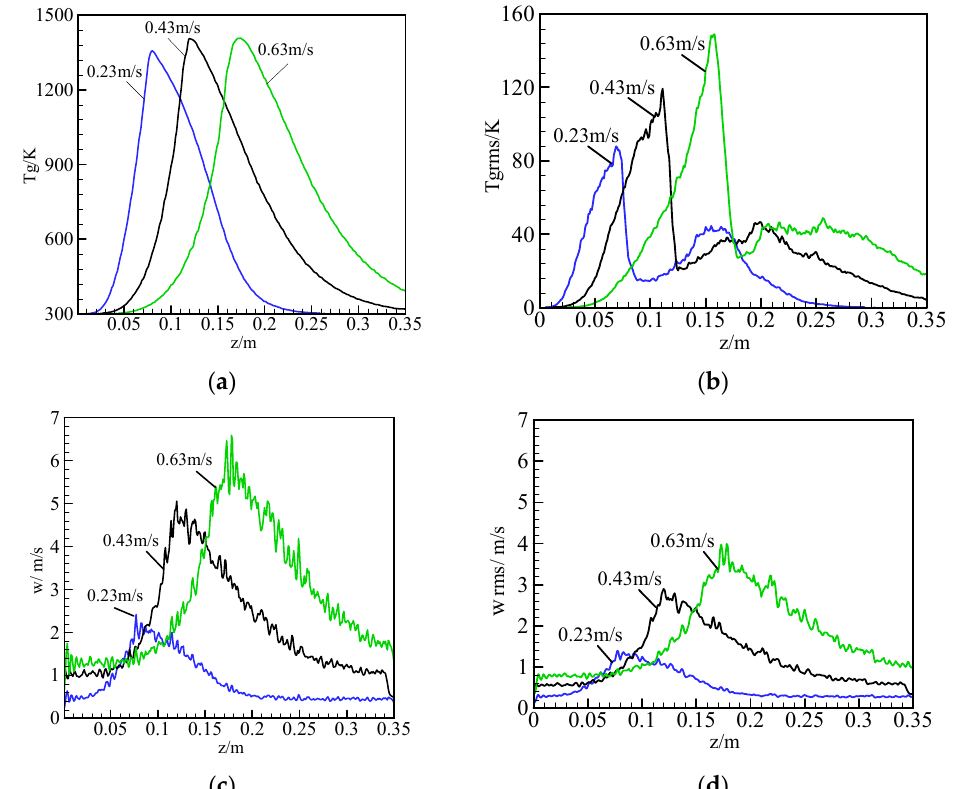
Figure 8. Effect of mixture velocity for average gas temperature and its root mean square, average axial velocity and its root mean square along the flow direction for equivalence ratio of 0.15 at time instant of 373 s. ( a ) T g /K. ( b ) T g,rms /K. ( c ) w /m/s. ( d ) w RMS/ m/s.